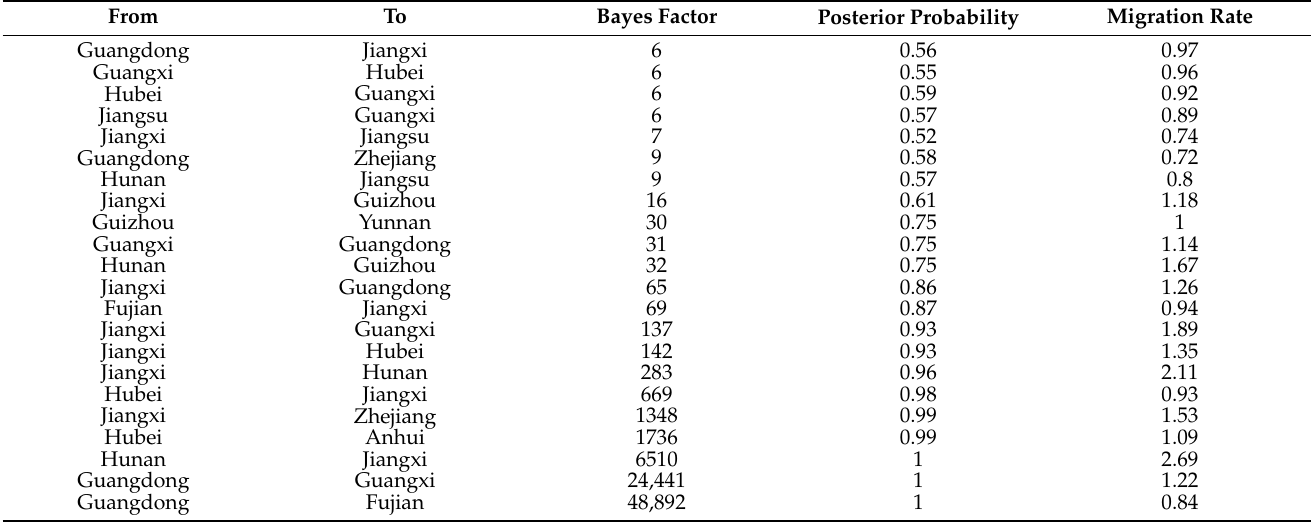
Figure 5. Spatiotemporal dissemination of H6Nx influenza viruses in China, which was determined by Bayesian phylogeographic inference of HA gene sequences. Curves show the among-province virus lineage transitions statistically supported with Bayes factor >3 for H6Nx influenza viruses. Curve widths represent transition rate values; curve colors represent corresponding statistical support (Bayes factor value) for each transition rate. Table 1. Statistically supported migration rates of H6Nx influenza viruses in China estimated from HA gene